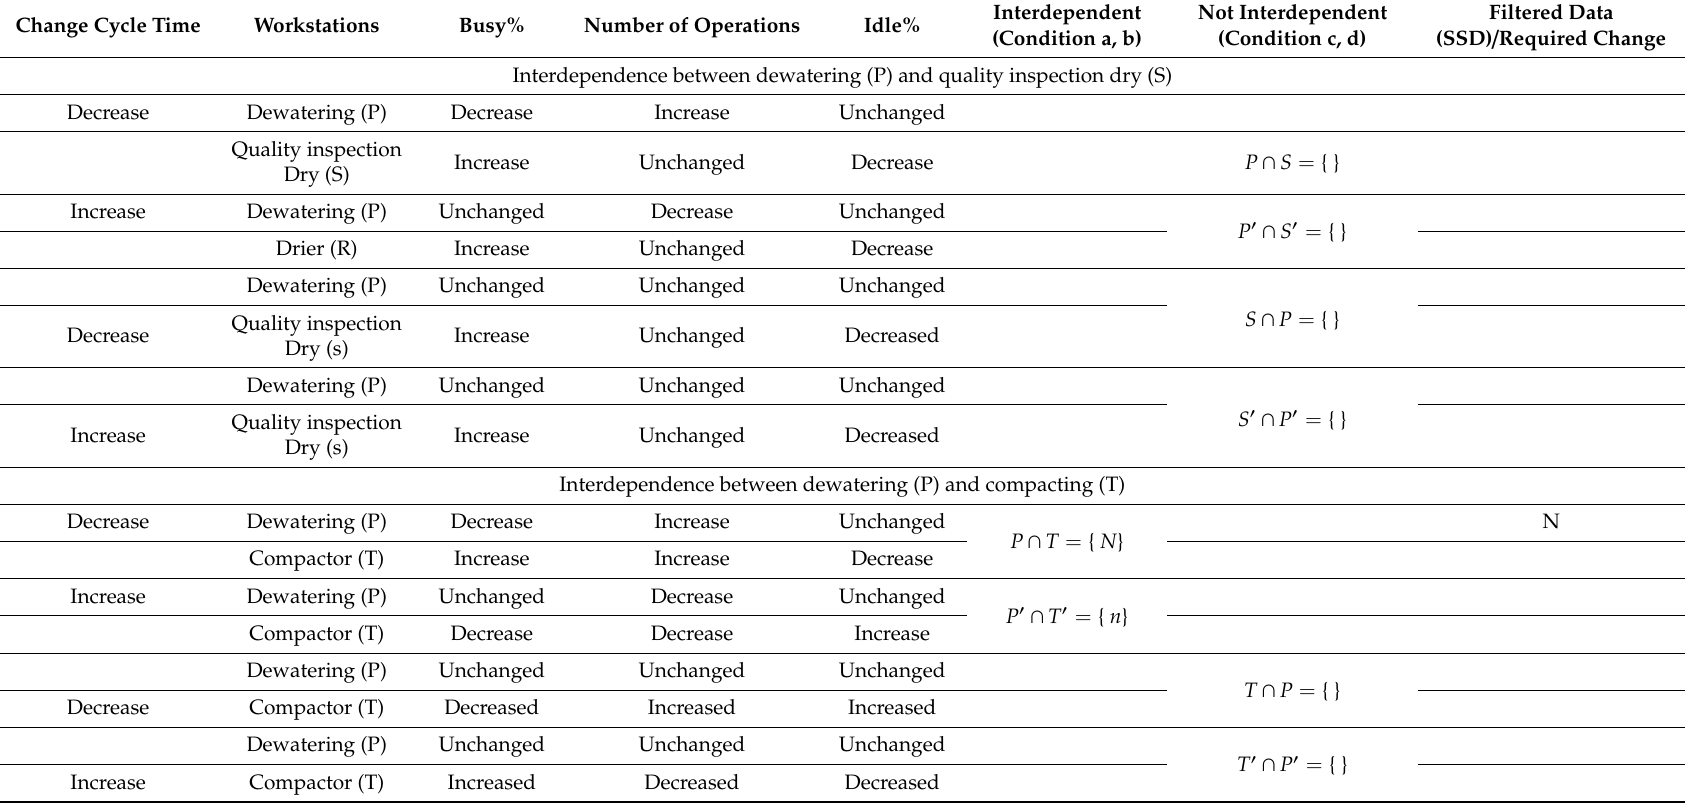
Table 2. Interdependence between the dewatering, quality inspection dry, and compacting